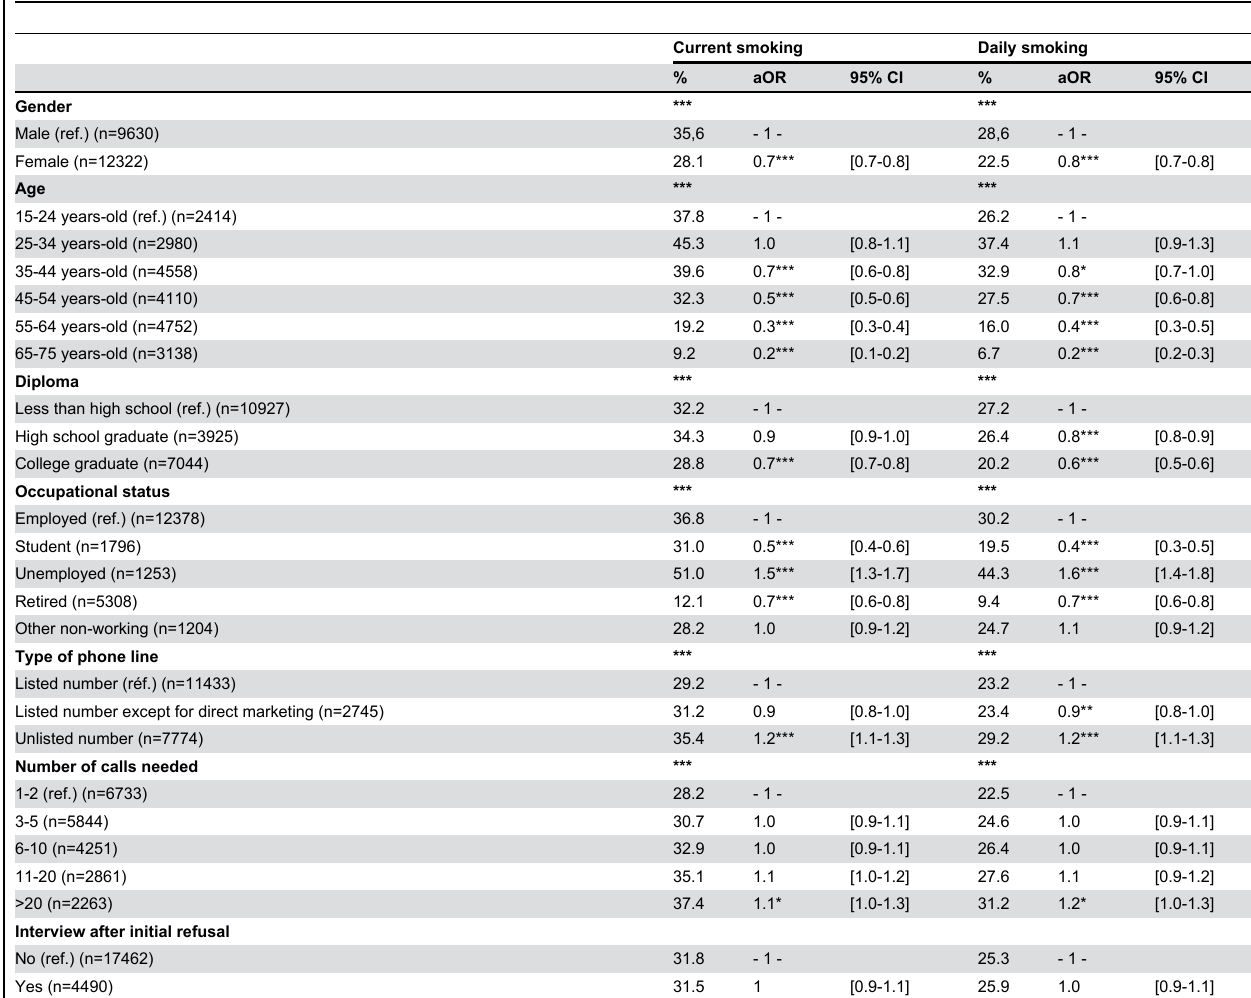
Table 5. Weighted percentages, adjusted odds-ratios (aOR) and 95% confidence intervals (CI) from logistic regressions on current and daily smoking among the Health Barometer landline phone owners